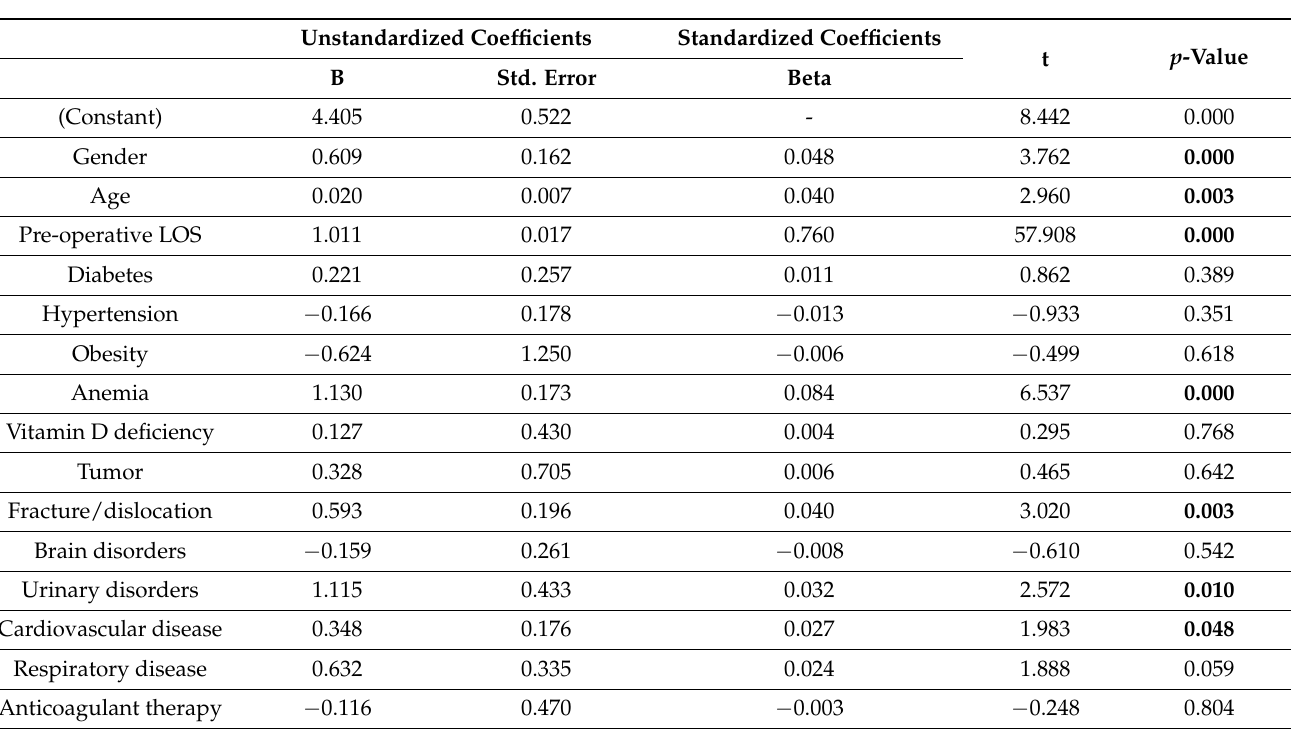
Table 3. Coefficients of MLR model.